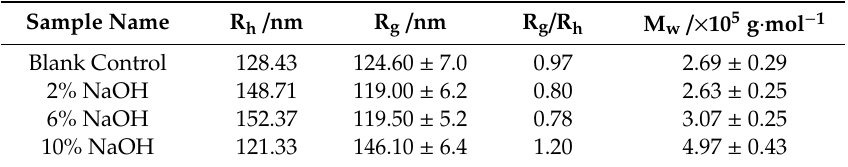
Table 3. Average molecular weight and R g / R h value of HAS films treated with di ff erent concentrations of